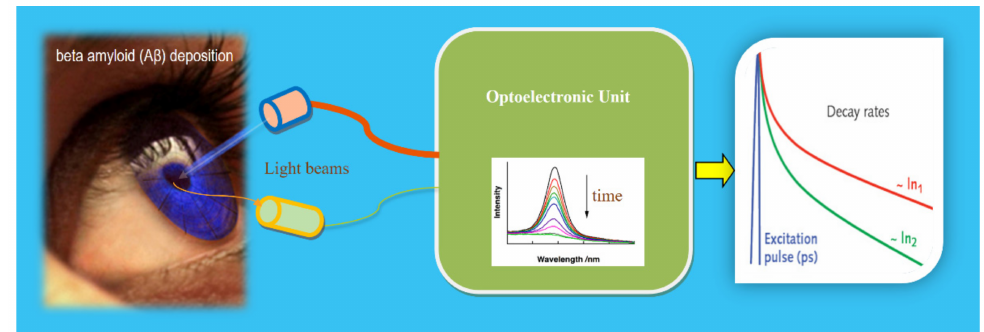
Figure 17. Illustration of a BioPhotonic Sensor (BioPS-FLES) for early detection of Alzheimer’s disease. The excitation laser pulsed light from the optoelectronic unit in the interaction with the lens of the eye provokes a fluorescent light (LM) that, after detection and adequate treatment in the OU, the output is given based on the decay times. The higher the beta-amyloid, the lower the fluorescent decay times [105]. Courtesy of the